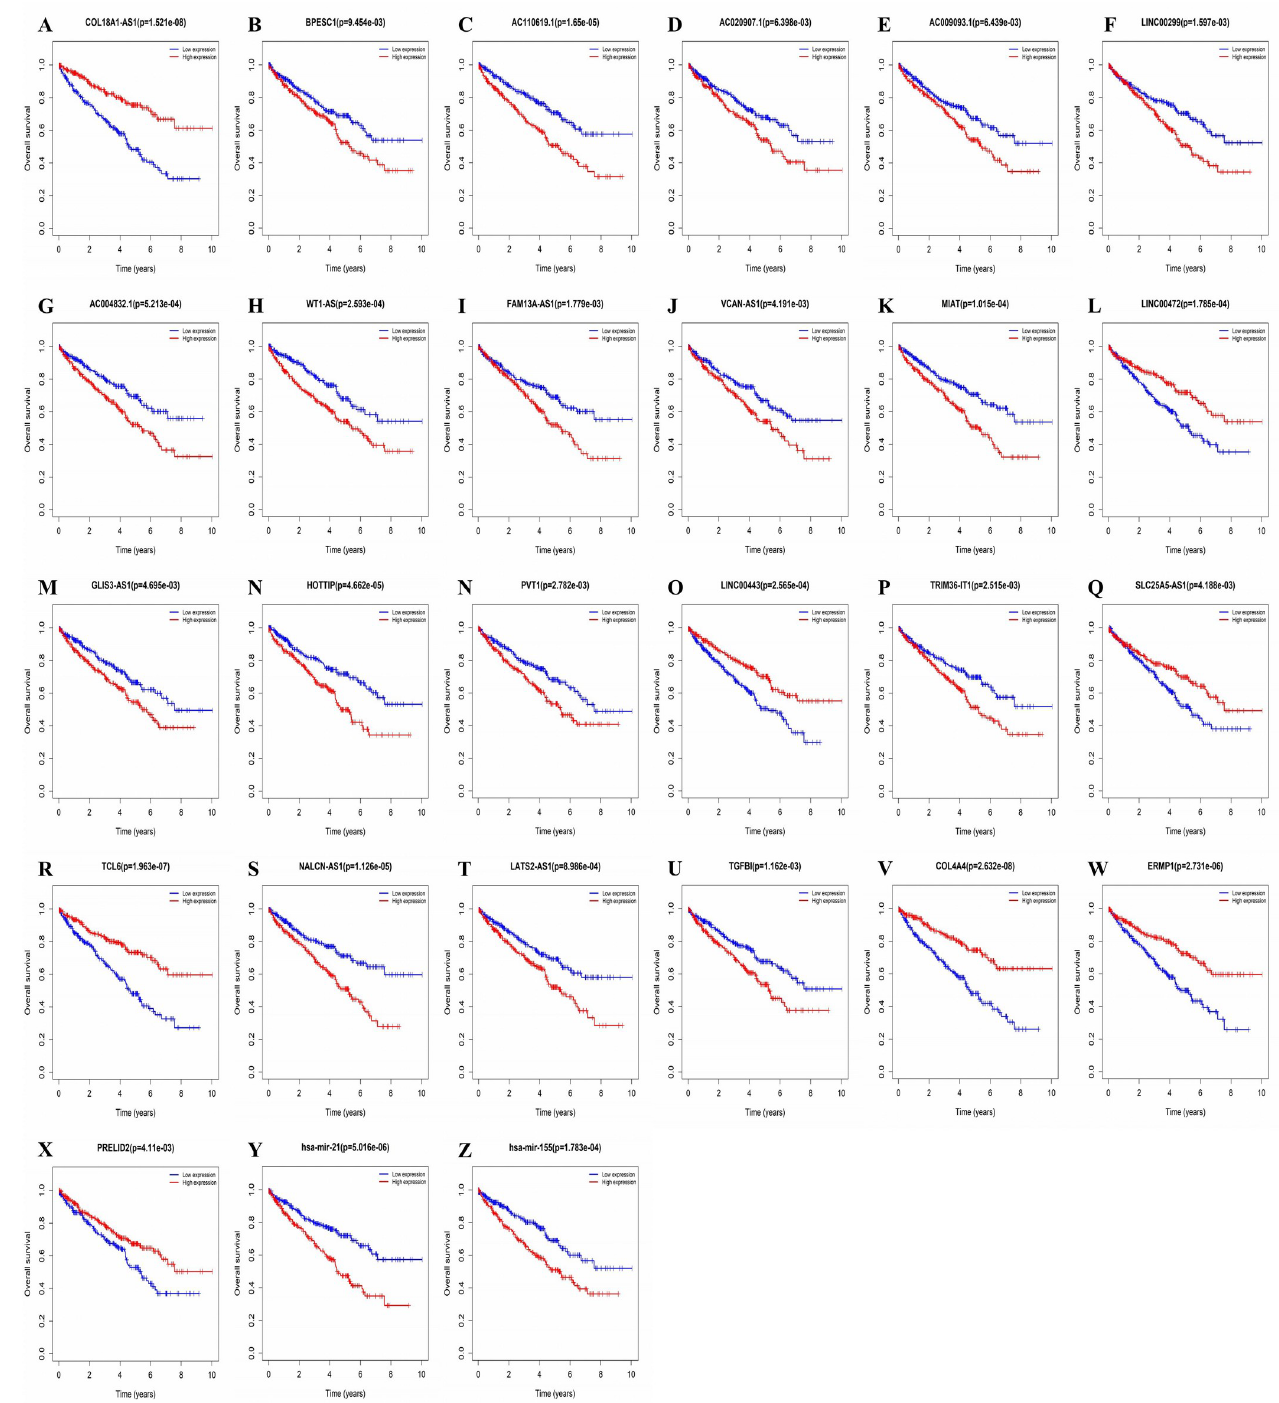
Fig 4. Kaplan–Meier curve analysis and overall survival rate of DElncRNA, DEmRNA, DEmiRNA in KIRC. (a-z) Represented COL18A1-AS1, BPESC1, AC110619.1, AC020907.1, AC009093.1, LINC00299, AC004832.1, WT1-AS, FAM13A-AS1, VCAN-AS1, MIAT, LINC00472, GLIS3-AS1, HOTTIP, PVT1, LINC00443, TRIM36-IT1, SLC25A5-AS1, TCL6, NALCN-AS1, TGFBI, COL4A4, ERMP1, PRELID2, hsa-mir-21, hsa-mir-155.